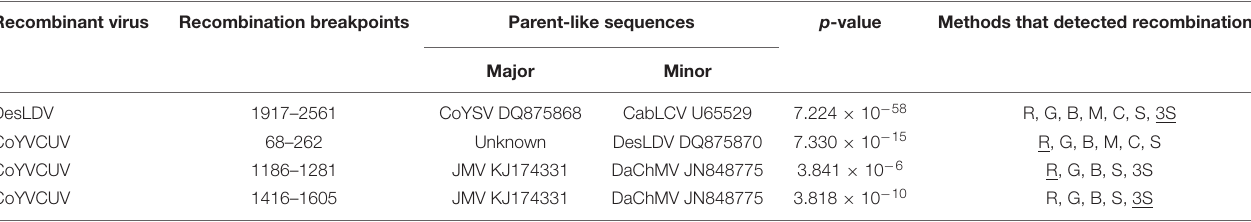
TABLE 3 | Recombinant fragments detected in the DNA-A sequences of Desmodium leaf distortion virus – (Cuba-Corchorus 706-2-2013) (DesLDV) and Corchorus yellow vein Cuba virus – (Cuba-Corchorus 706-1-2013) (CoYVCUV) by at least five methods included in the RDP4 package.